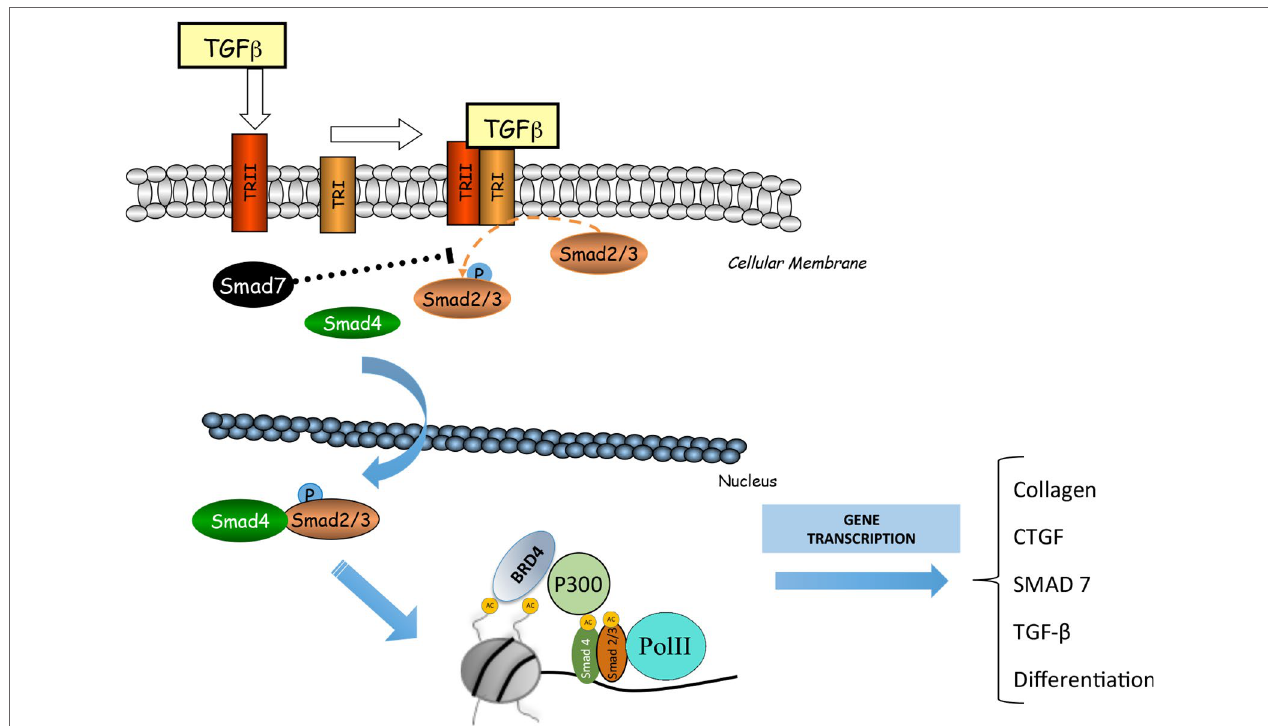
FIGURE 4 | BRD4 is involved in the transforming growth factor β (TGF-ß)/SMAD signaling pathway. BRD4 interacts with the components of this signaling pathway to regulate the expression of genes related to the synthesis of extracellular matrix proteins (MEC) and